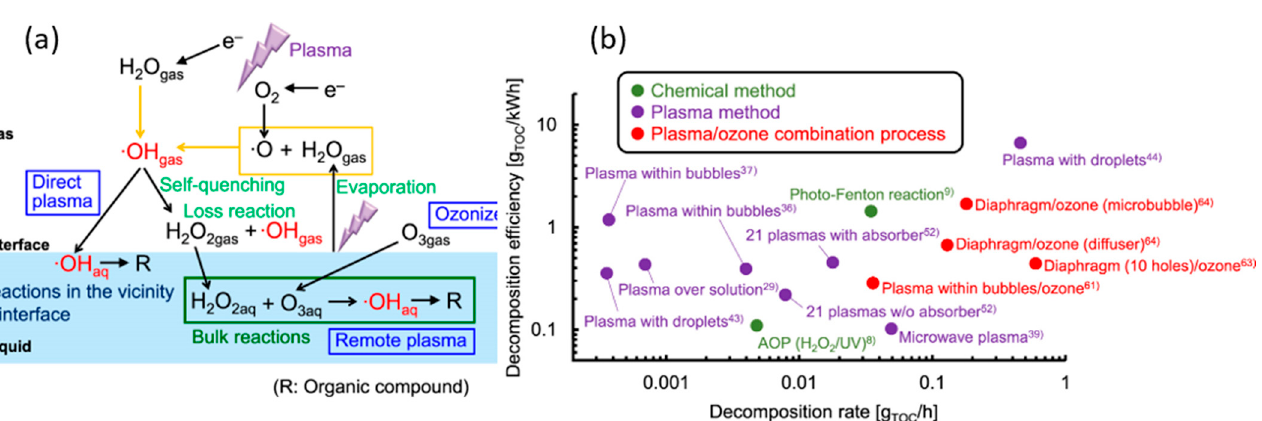
Figure 4. Variation of energy efficiency for ozone synthesis with electric field strength in DBD (Reprinted from [75]).